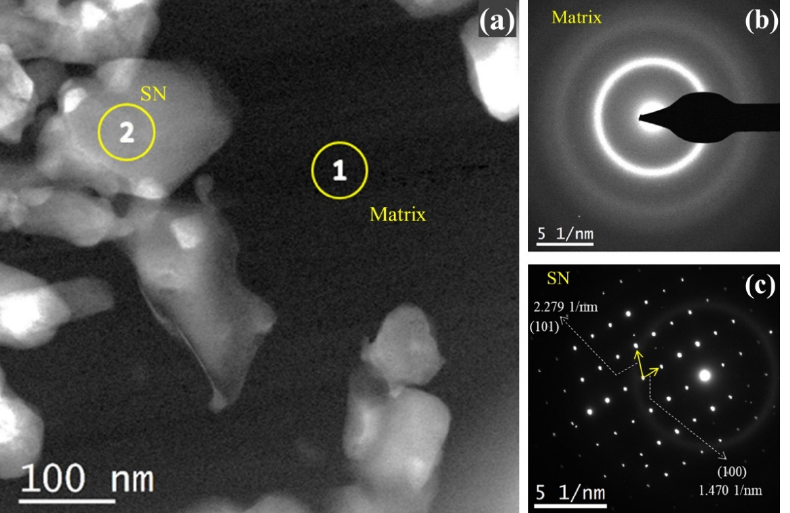
Figure 3. ( a ) TEM image of Ni-P-SN composite coating; ( b ) the SAED pattern obtained from the matrix indicated by circle ‘1’; ( c ) the SAED pattern obtained from the particle indicated by circle ‘2’ in ( a ). The SAED pattern of the matrix is diffused circular rings indicating the matrix is in the amorphous phase, while the SAED pattern of the SN nanoparticle is composed of bright diffraction spots indicating the crystalline nature of the nanoparticle.